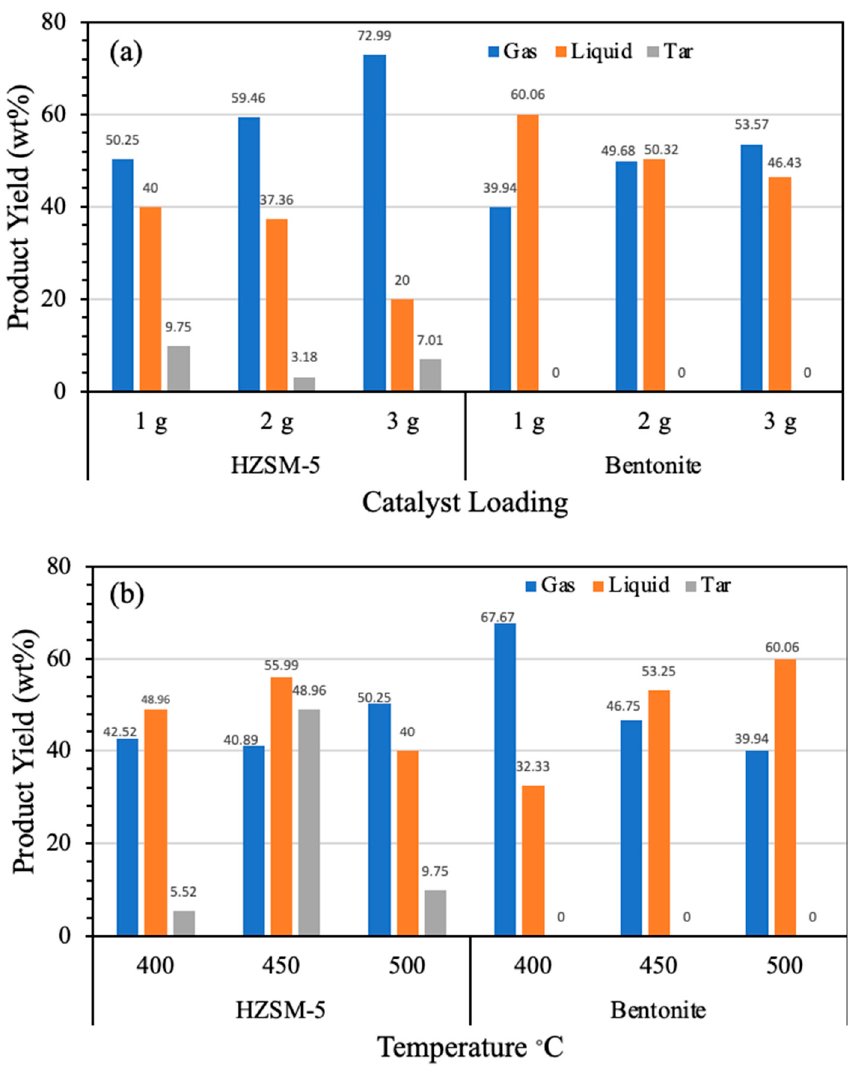
Figure 4. Comparative effect of catalyst usage on product distribution at 500 °C (a) and temperature on product distribution using 1 g of catalyst (b).